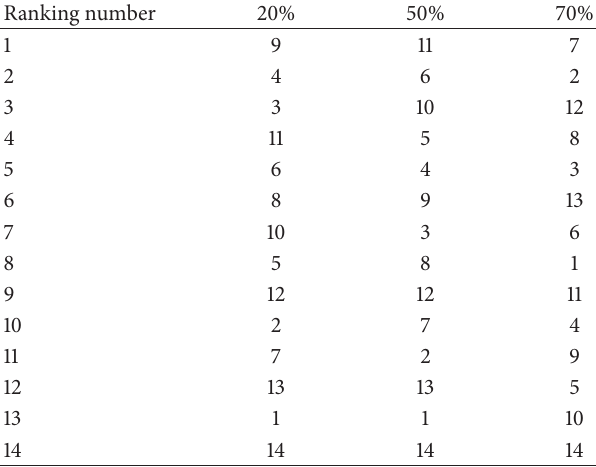
Table 5: Performance ranking of cipher text image by descending order in Figure 3 with normalized autocorrelation in different directions.